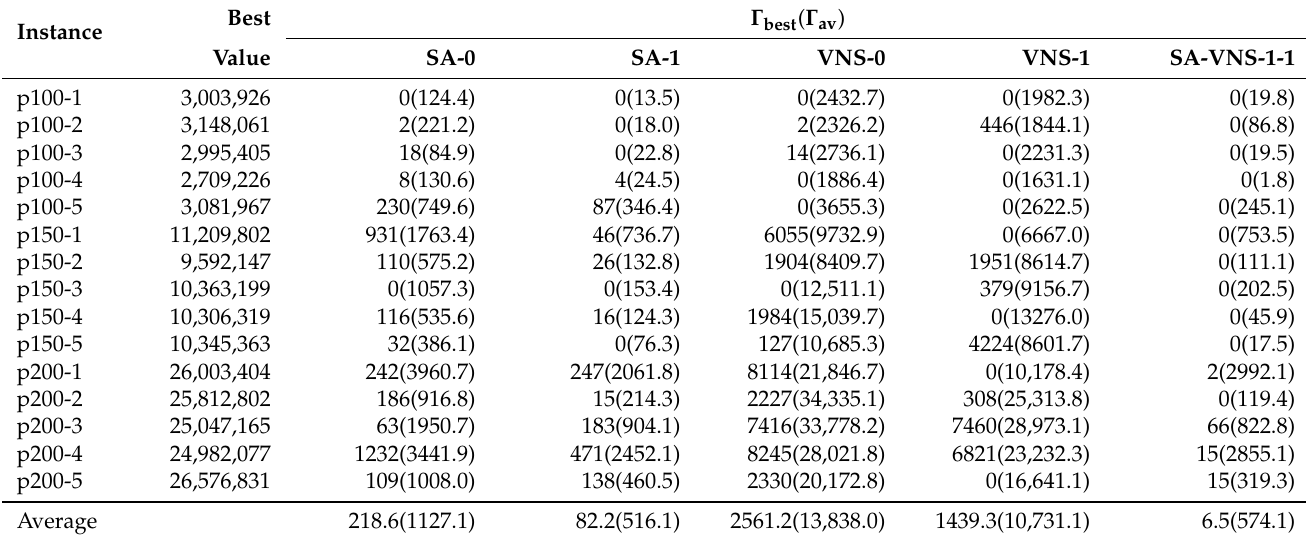
Table 1. Comparison of various configurations of SA and VNS against their combination: best ( Γ best ) and average ( Γ av ) solution gaps to the best objective